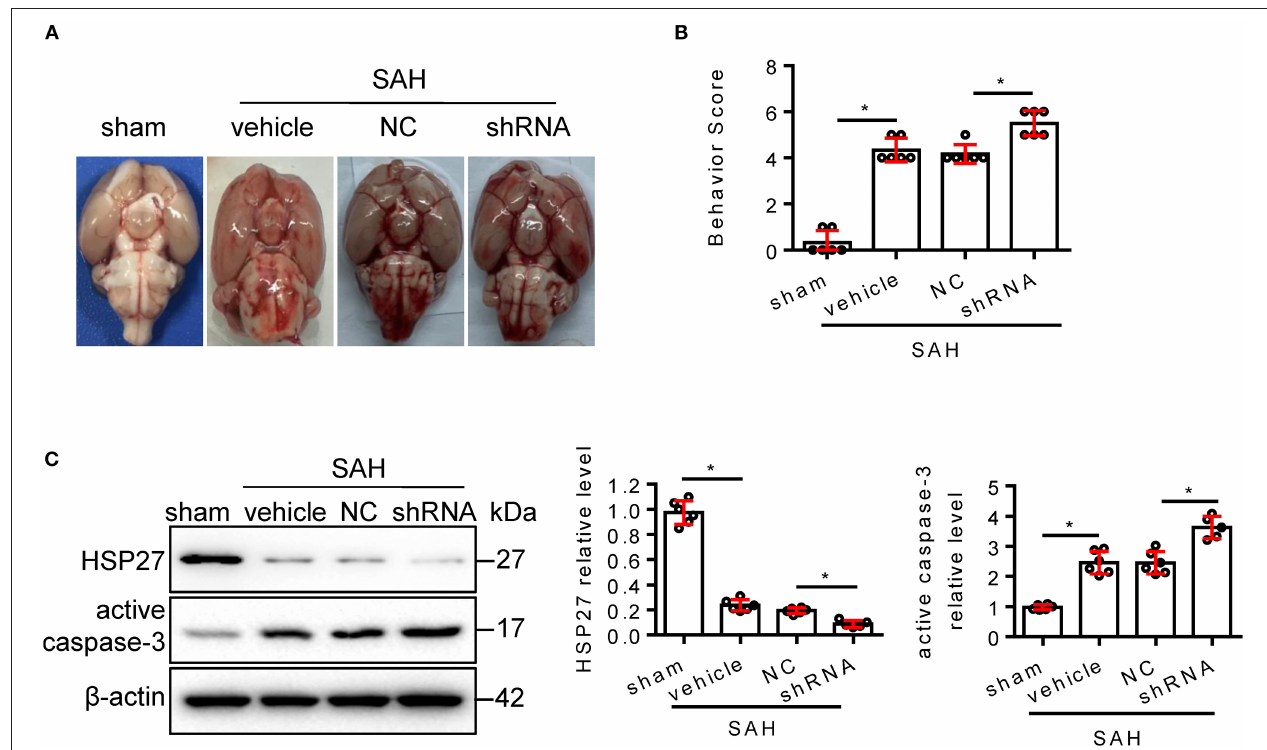
FIGURE 4 | AAV-shRNA targeting HSP27 deteriorated neurological deficit after SAH in rats. (A) Representative images of rat brain on day 2 after surgery for the sham, SAH + vehicle, SAH + NC, and SAH + shRNA groups. (B) Behavior scores of each group were assessed at 48h, n = 6. (C) The basal cortex was collected on day 2 following SAH from the sham ( n = 6), SAH + vehicle ( n = 6), SAH + NC ( n = 6), and SAH + shRNA ( n = 5) groups; homogenates were blotted with anti-HSP27, anti-active caspase-3, and anti- β -actin, quantification of optical density was normalized to sham group. Data are mean ± SD, * p < 0.05, ANOVA with Bonferroni’s multiple comparisons